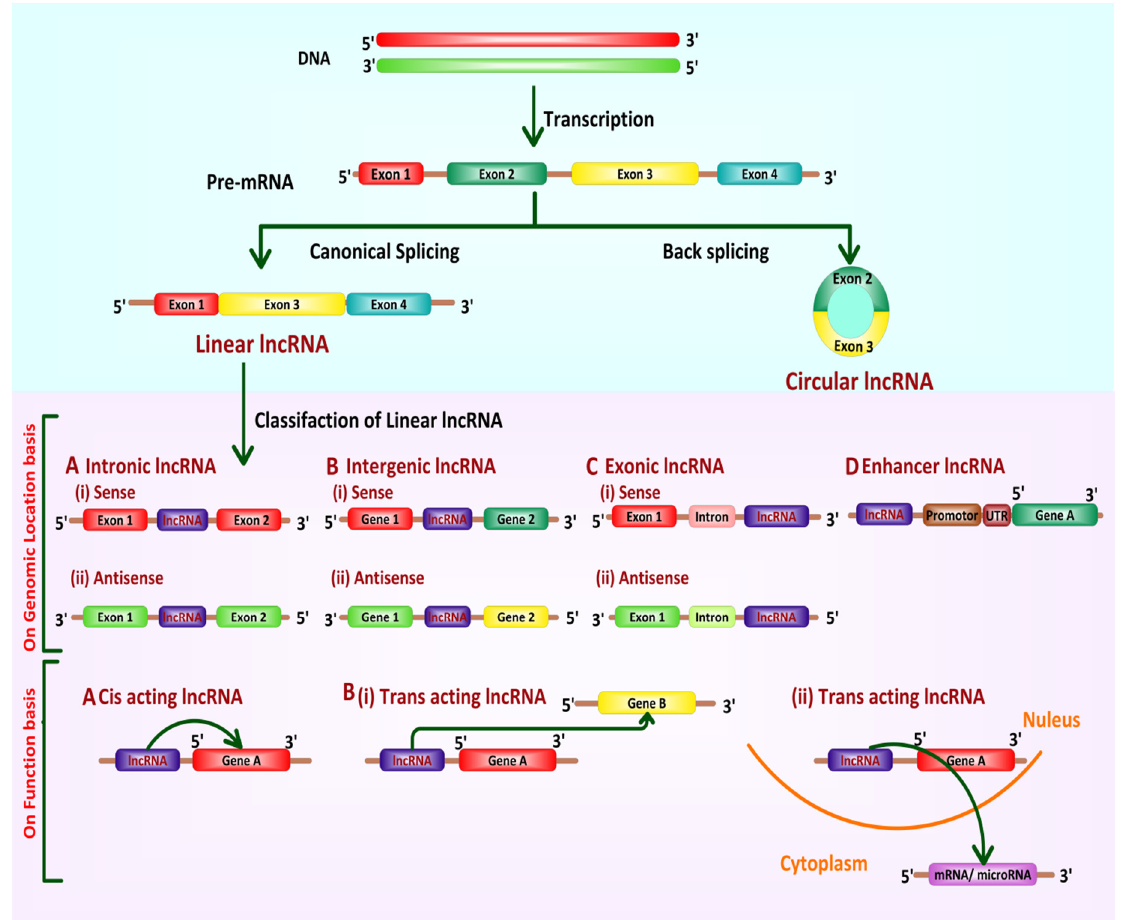
Figure 2. Biogenesis and classification of lncRNAs. Canonical splicing produces linear lncRNA while circular lncRNA is made via back splicing. Linear lncRNAs are further categorized based on their genomic location, direction of transcrip- tion (A= (i) Sense and (ii) Antisense intronic lncRNA, B = (i) Sense and (ii) Antisense intergenic lncRNA, C = (i) Sense and (ii) Antisense exonic lncRNA, and D = Enhancer lncRNA) and on their functions (A = Cis-acting lncRNA and B = (i) & (ii) Trans-acting